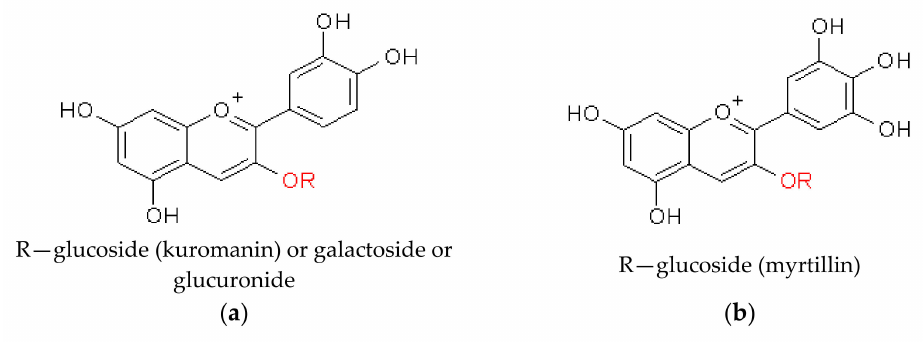
Figure 4. Structure of the most common anthocyanins: ( a ) cyanidin derivatives; ( b ) delphinidin derivatives found in Nepenthaceae and Droseraceae